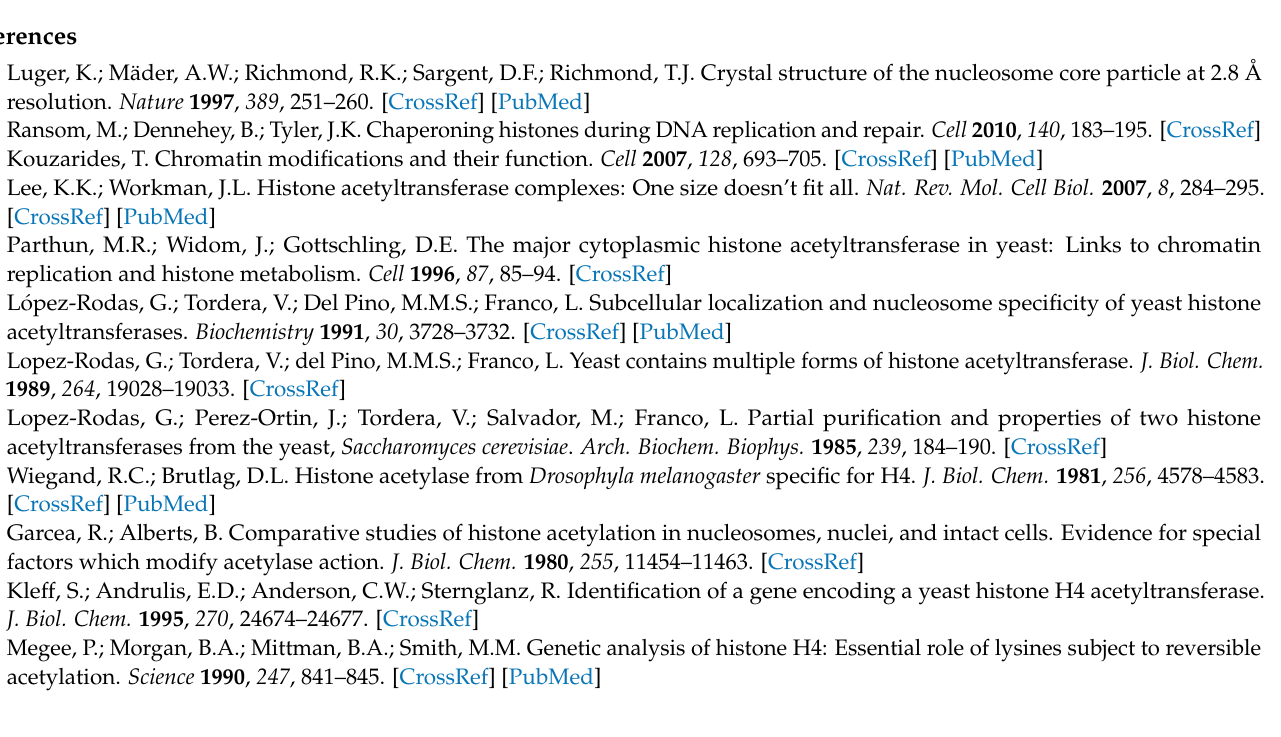
Figure 9. A model describing the potential mechanism of action of the Hsm3p as part of NuB4 complex. This model describes an approximate mechanism of action of Hsm3p, as a subunit of the histone acetyltransferases complex NuB4. Most likely, Hsm3p joins in the Hat1p/Hat2p complex, as well as